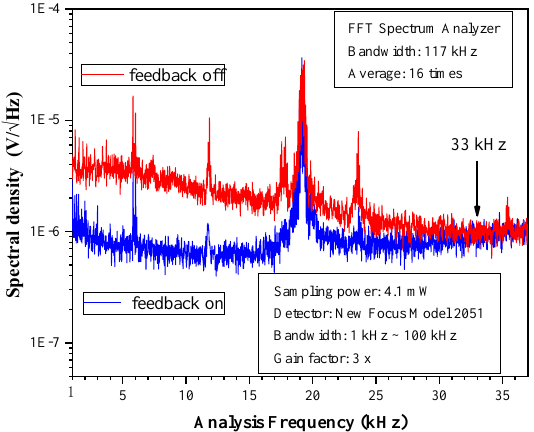
Figure 8. Intensity fluctuation of laser in the time domain in the free-running case and the feedback-on case. The light intensity is suppressed from ± 3.360% to ± 0.064%: 1.6 W for a total power of the 1064-nm laser, and the sampling power is 4.1 mW ( b ), zooming of the feedback-on case in ( a ).